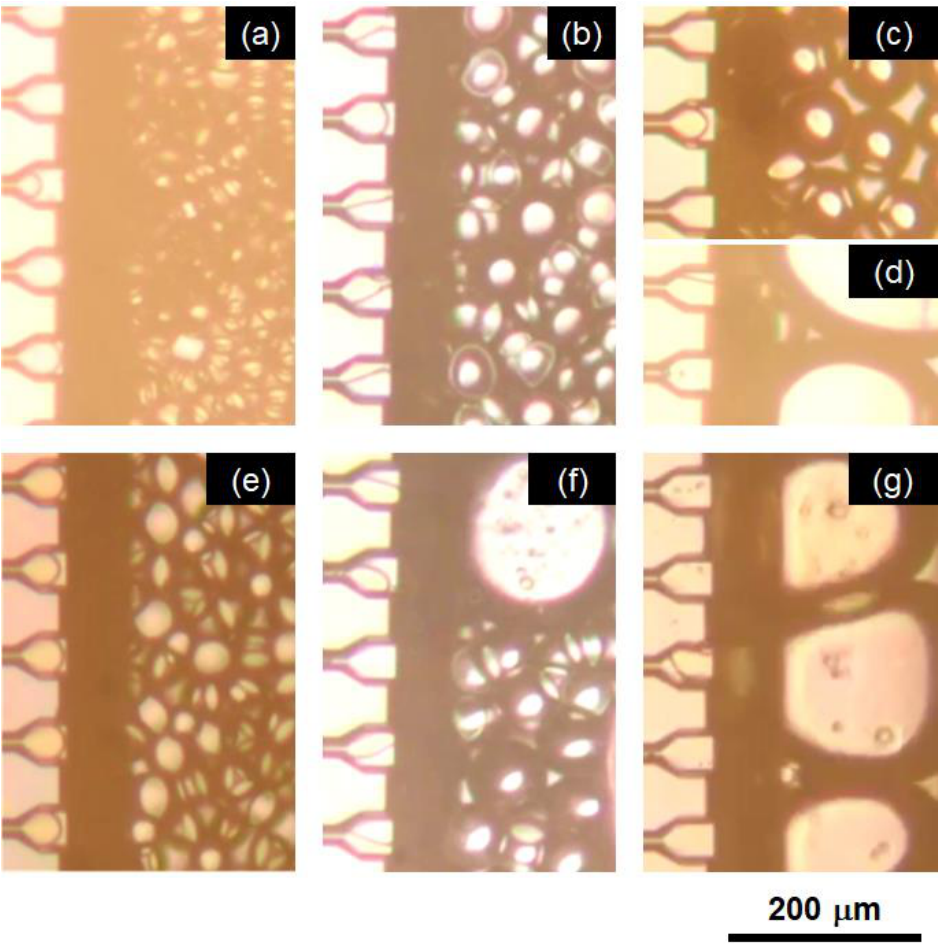
Figure 1. Effect of emulsifier types on emulsification at 60 °C with microchannel plate type A (MC-A, see Section 3.2.) using ( a ) sodium dodecyl sulfate (SDS), ( b ) hexaglycerin monolaulate (HGML), ( c , d ) Tween 80, ( e ) sodium caseinate (SC), ( f ) β -lactoglobulin ( β -LG), and ( g ) skimmed milk powder. The concentration of each emulsifier was 3